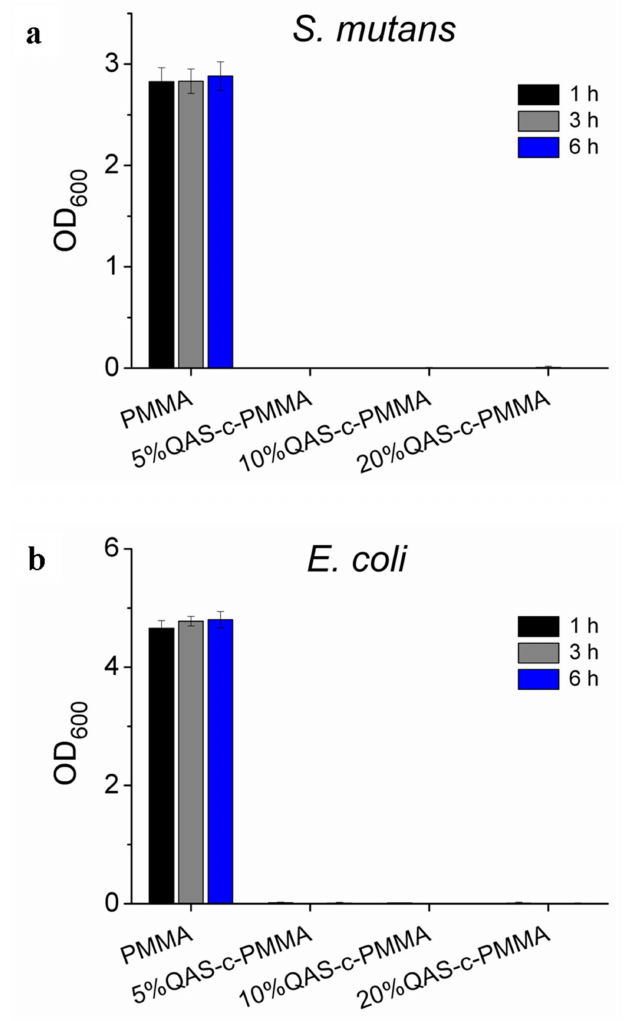
Figure 2. Antibacterial adhesion tests: ( a ) Streptococcus mutans and ( b ) Escherichia coli . All PMMA chemically bonded to QAS demonstrated antibacterial